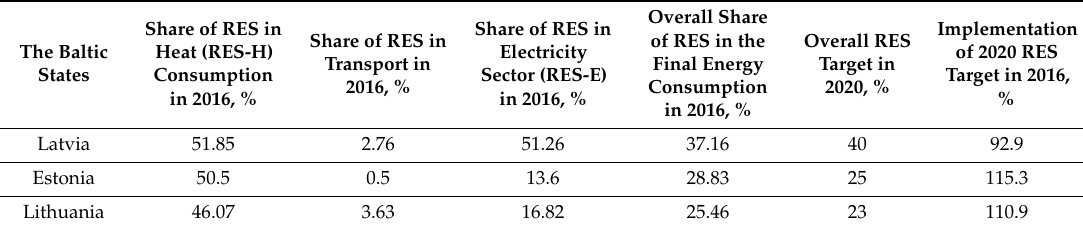
Table 2. National RES targets for the Baltic States in 2020 and results achieved in 2016. Source: created by the authors based on